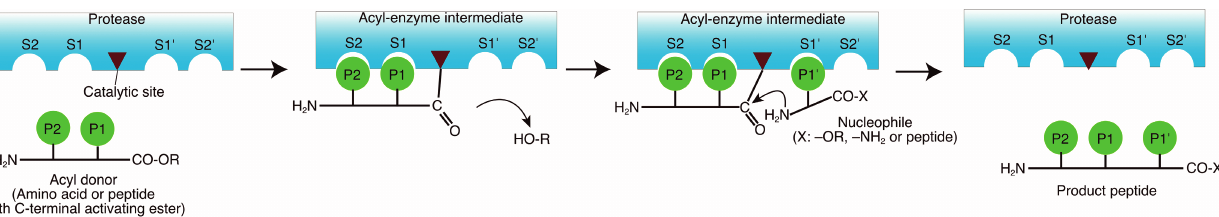
Figure 1. Protease-catalyzed peptide synthesis according to the nomenclature by Schechter and Berger